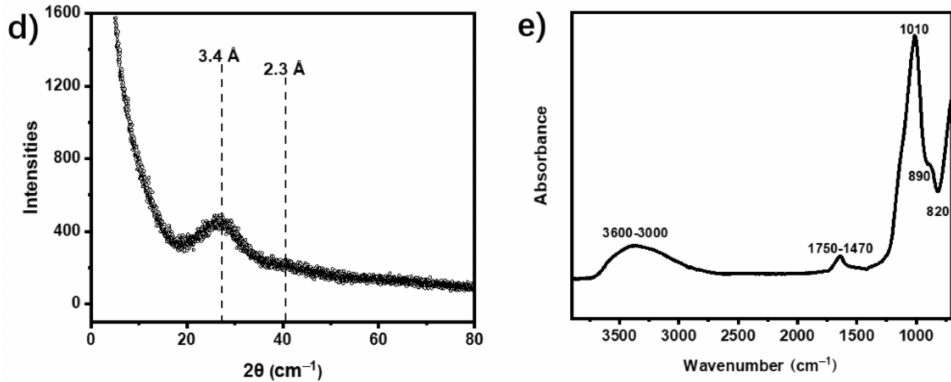
Figure 2. Transmission electron microscopy (TEM) images of synthetic allophane showing spherical ( a,b ) and hollow ( c ) morphology of allophane. PXRD pattern ( d ) and FTIR spectra ( e ) for synthetic